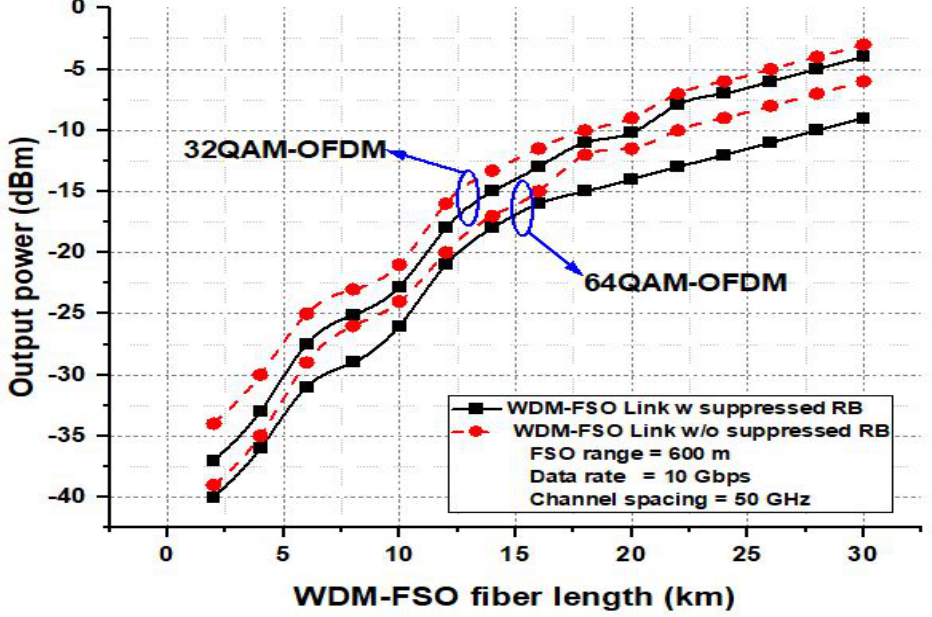
Figure 6. Fiber length estimations against Q-factor for matching the outcomes of suppressed RB based WDM-FSO and without suppressed RB based WDM FSO link.